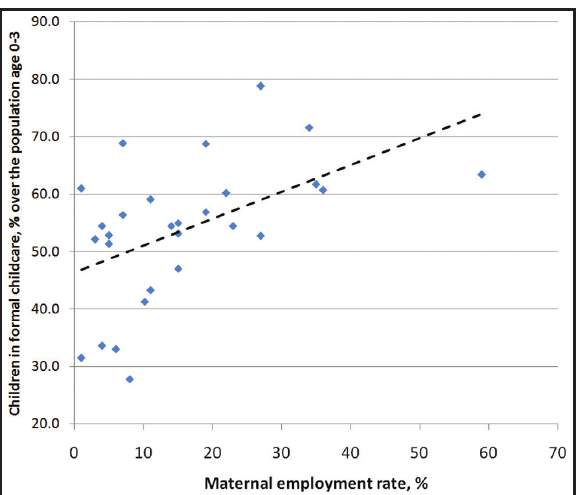
Figure 3 Relationship between maternal employment and child enrollment in formal child care, 2012.